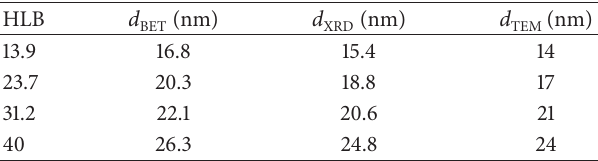
Table 1: Average particle size determined by TEM, BET, and XRD techniques.